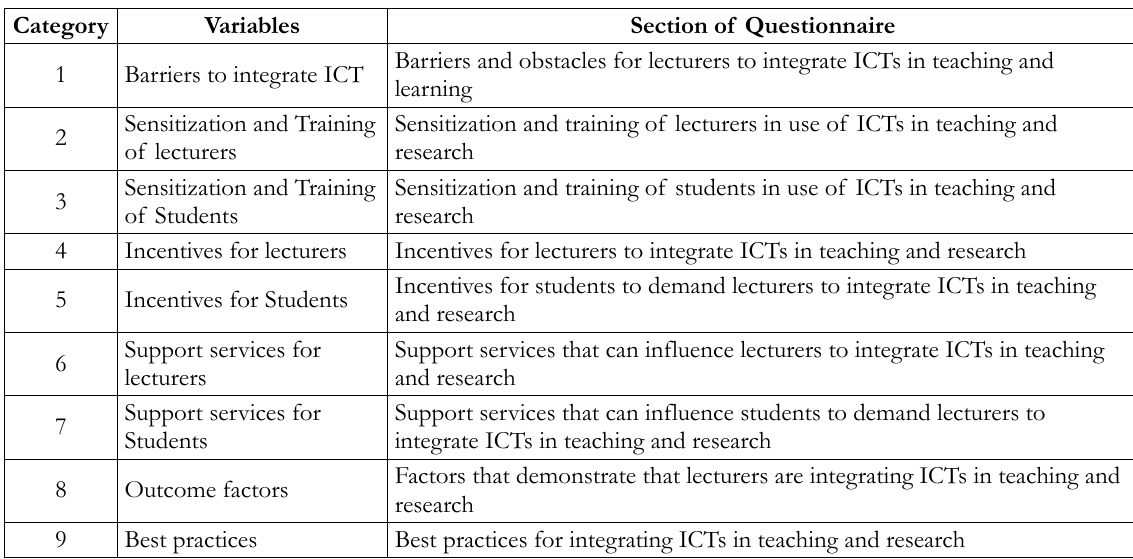
Table 2. Questionnaire